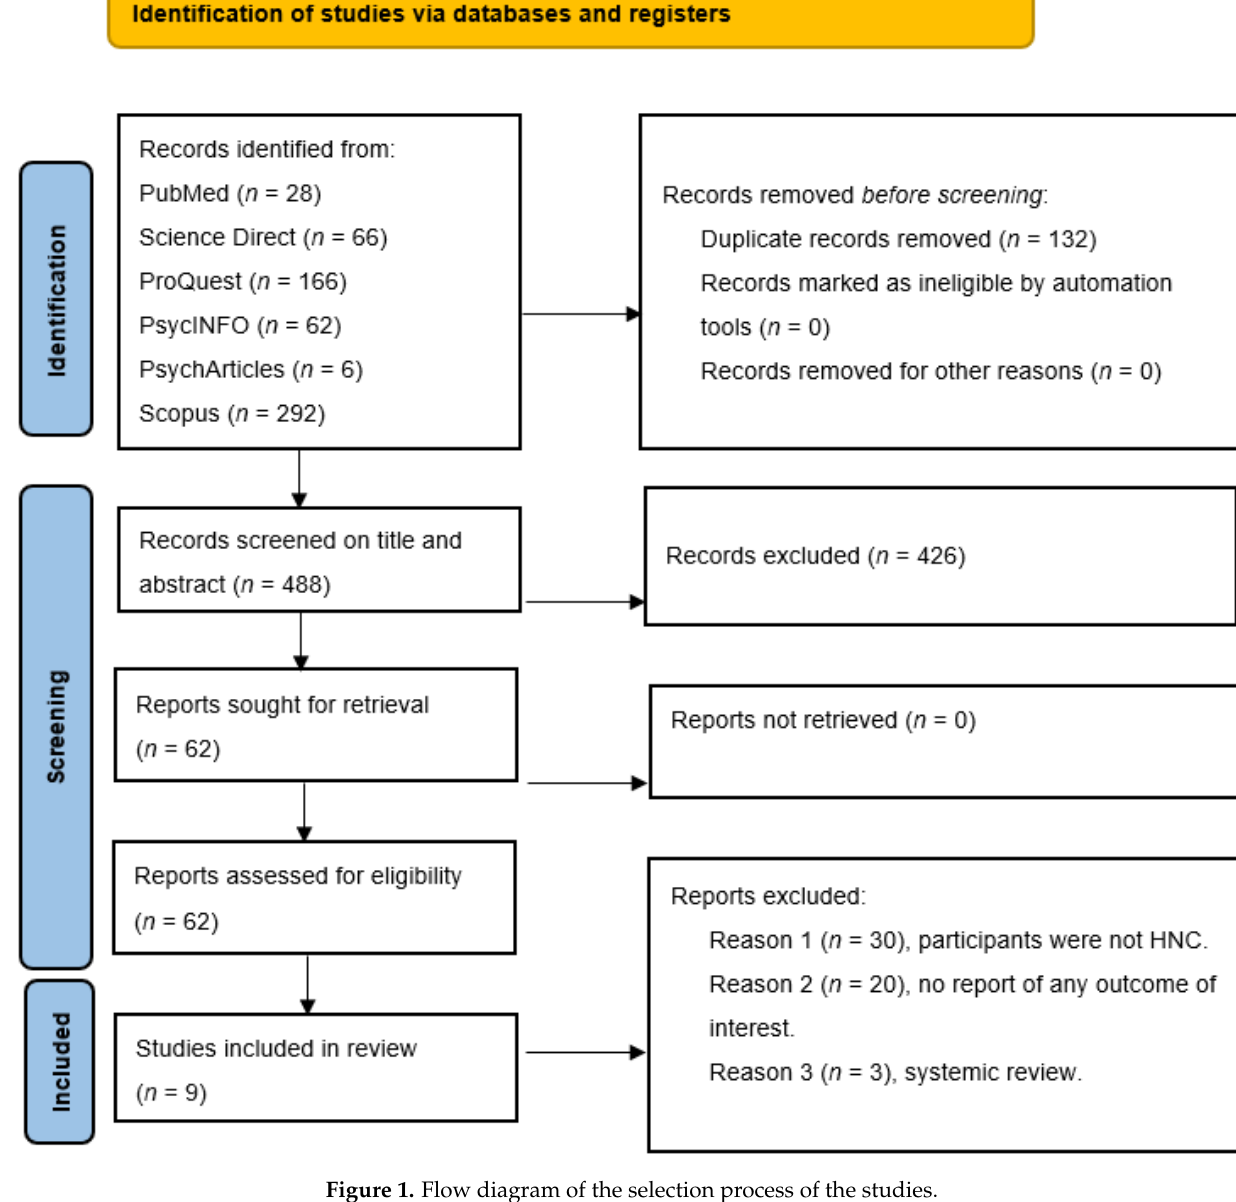
Figure 1. Flow diagram of the selection process of the studies .